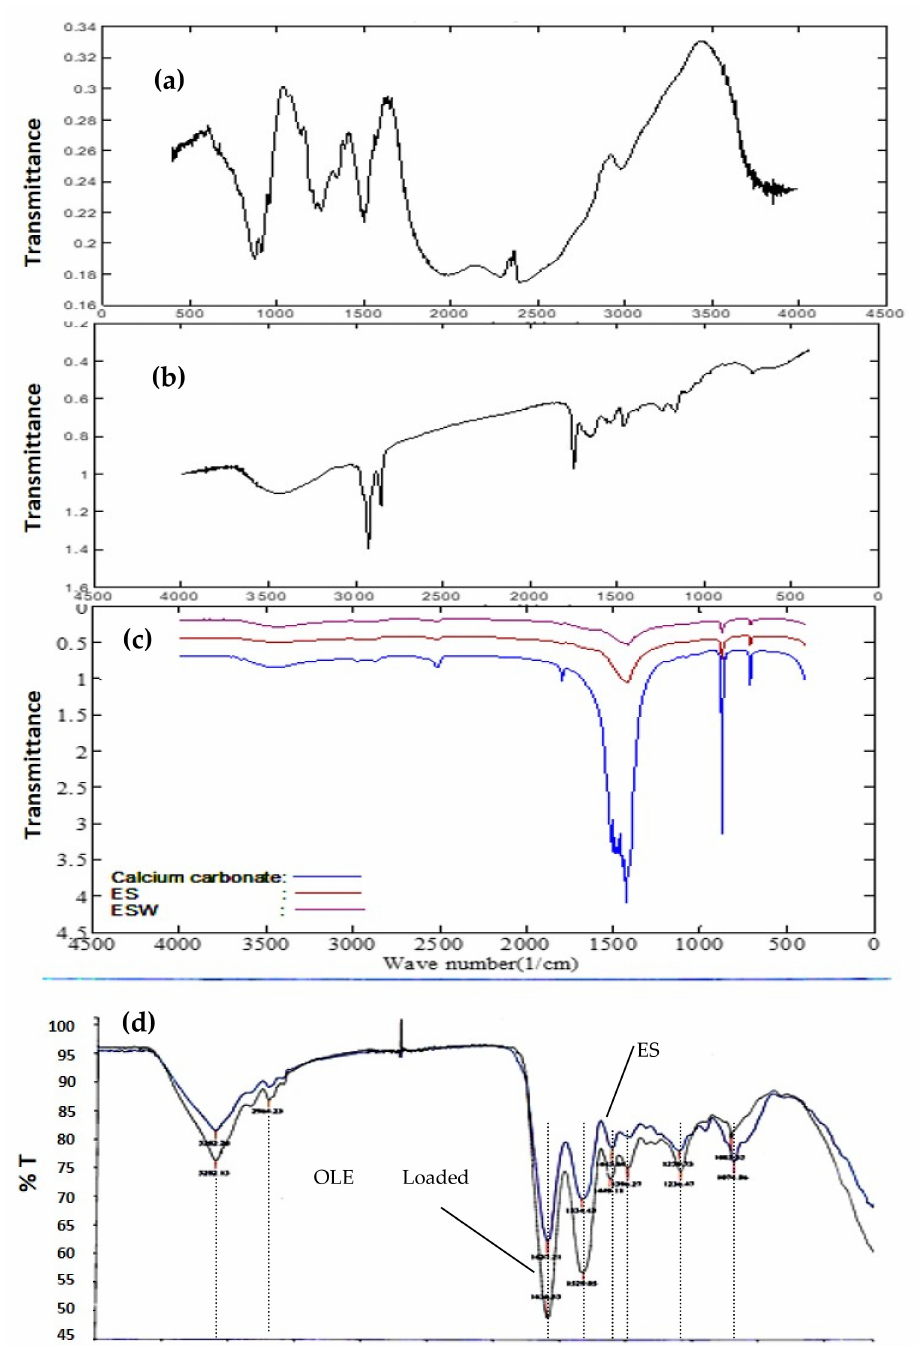
Figure 3. FTIR spectra of the ( a ) hyaluronic acid; ( b ) collagen; ( c ) eggshell waste (ESW), eggshell (ES), and calcium carbonate; and ( d ) eggshell membrane (ESM) and olive leaf extract (OLE)-loaded eggshell membrane (ESM). Figure 4 shows images of the separated eggshell and eggshell membrane after the foam separation